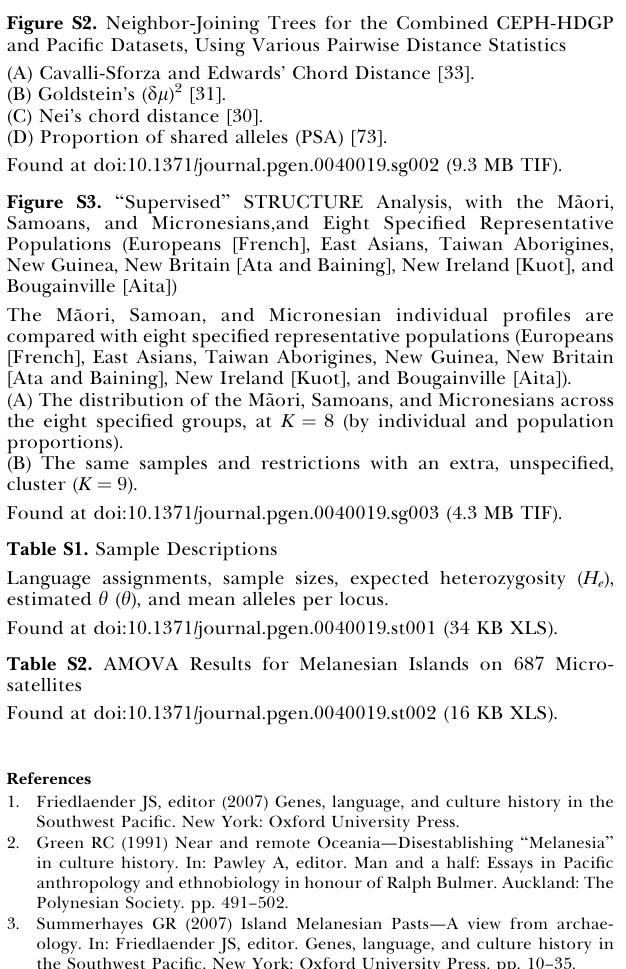
Table S3. Reproducibility of STRUCTURE Runs on the Combined Datasets Table S4. Matrix of Pairwise F ST ‘‘ Coancestry ’’ Distances (or Reynolds’ D) for the Combined HGDP-CEPH and Pacific Datasets Table S5. Reproducibility of STRUCTURE Runs on the Asia–Pacific Dataset Table S6. Cluster Assignment Probabilities ( K ¼ 10) of Pacific Populations, plus HGDP-CEPH East Asian and French Samples Table S7. Asia–Pacific Pairwise F ST Coancestry Distance Matrix Table S8. Austronesian Coancestry Proportions across 15 Most Consistent Runs (Similarity Coefficients . 0.90) Table S9. Changes to Allele